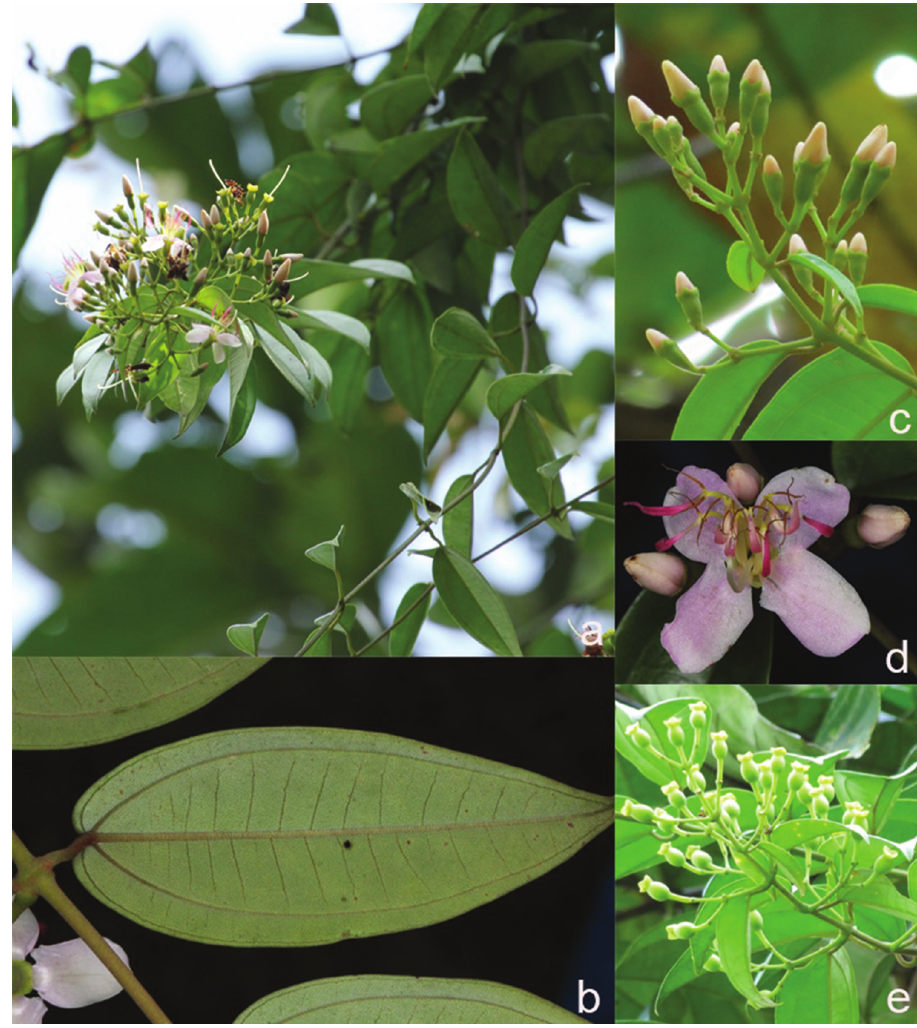
Figure 22. Dissochaeta pallida a habit b branchlet c hypanthium d flower e fruits. Photographs by W.F.